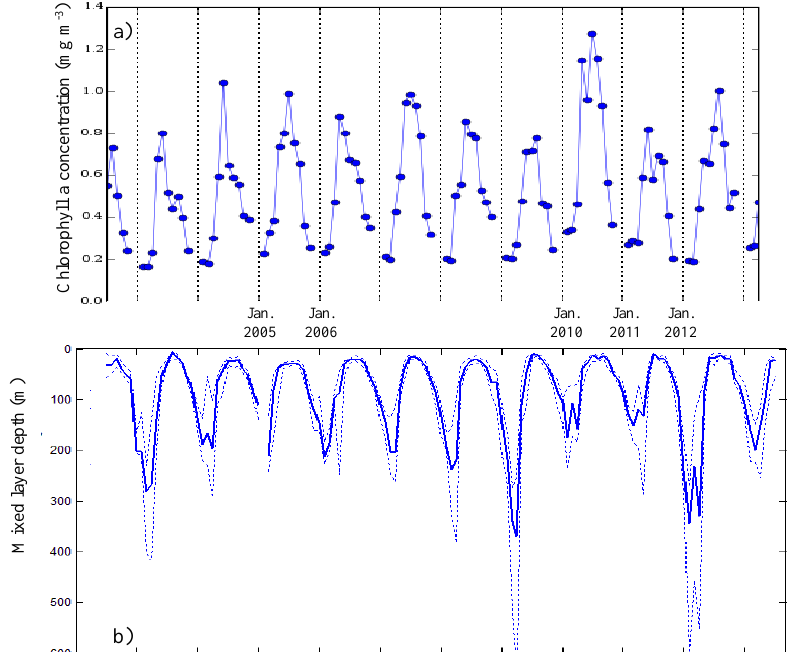
Fig. 4: Distribution of a) Chlorophyll a concentration from MODIS-Aqua 4 km (disc.sci.gsfc.nasa.gov/giovanni, time series generated between 44°W-27°W and 53°N-62°N) and of b) mixed layer depth (MLD, m) from Argo-float observations in Fig. 4. Distribution of (a) chlorophyll a concentration from MODIS-Aqua 4km (disc.sci.gsfc.nasa.gov/giovanni, time series generated be- NASPG. The MLD is estimated on each profile as the depth at which temperature deviates by 0.1°C from the temperature at tween 44 ◦ W–27 ◦ W and 53 ◦ N–62 ◦ N) and of (b) mixed layer depth (MLD, m) from Argo-float observations in NASPG. The MLD is 5m. The full line represents the median depth whereas the dashed lines correspond to the first and third quartiles estimated on each profile as the depth at which temperature deviates by 0.1 ◦ C from the temperature at 5m. The full line represents the median depth, whereas the dashed lines correspond to the first and third